Question: Sum up the contents of this chart in one sentence.
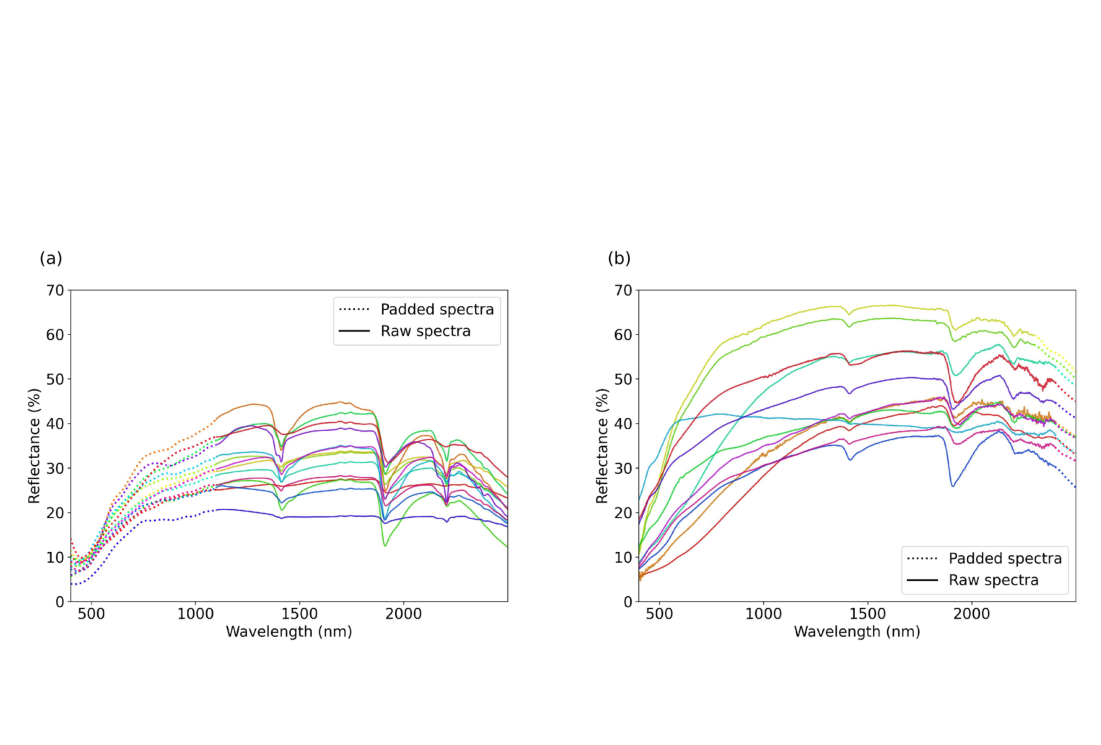
Answer: Full-range spectra obtained by applying the spectra padding model to (a) Barth`es2023 and (b) MARMIT2020 datasets. The solid curves represent the original spectra, and the dotted curves are the reconstructed portion of the spectra.